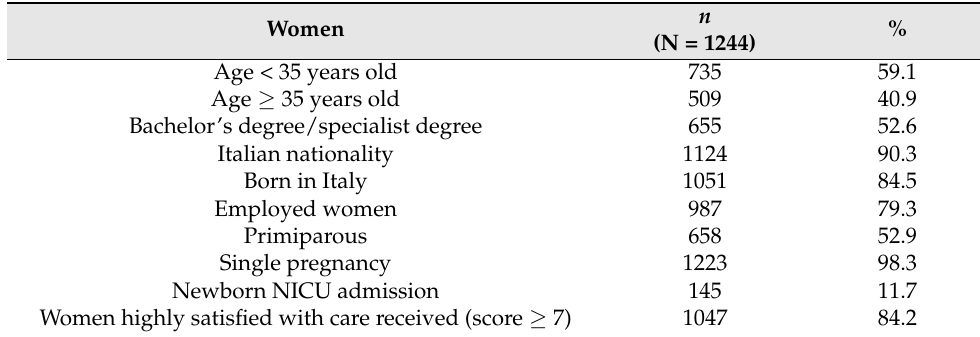
Table 1. Characteristics of the sample, clinical procedures and overall women’s satisfaction with care